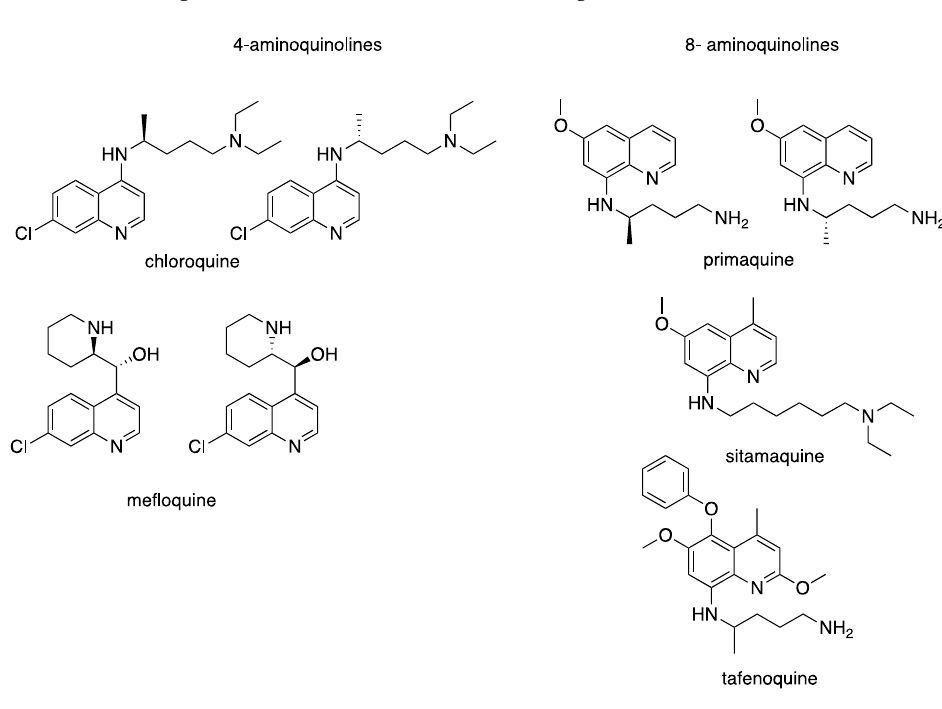
Figure 2. Aminoquinolines with antileishmanial activity. Among the 4-substituted quinolines, chloroquine and mefloquine are active in vitro against L. amazonensis intracellular amastigotes [15]. In a clinical trial, chloroquine